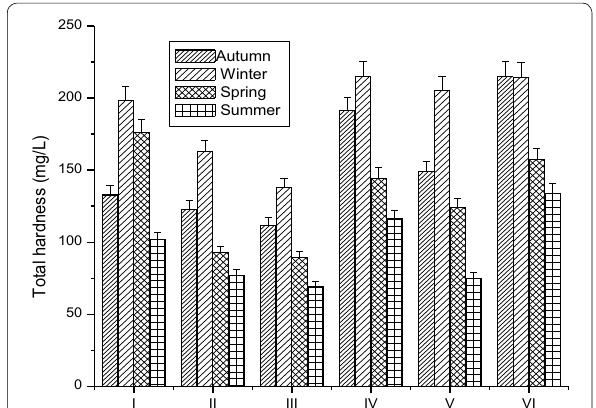
Fig. 10 Spatial and temporal variations of total hardness (mg/L) in